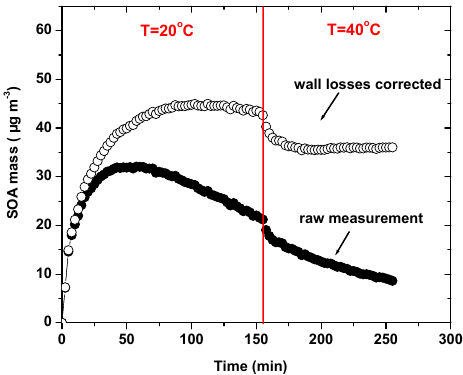
Figure 2. The SOA yield versus the total mass produced (for w = 1). The red dots are the results of this study from the unseeded ex- periments, and the black dots are results from the experiments in which ammonium sulfate seeds were used. The open symbols are the results of Chen et al. (2012). The solid line is the fitting of the data from both studies using the volatility basis set (VBS) frame-